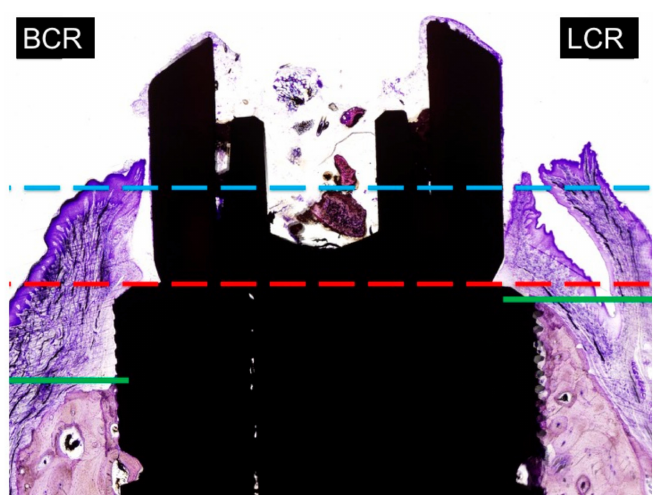
Figure 7. Measurements of marginal bone loss: BCR: buccal crest resorption (distance from the top of the implant shoulder to the first BIC in the buccal crest side. LCR: lingual crest resorption (distance from the top of the implant shoulder to the first BIC in the lingual crest